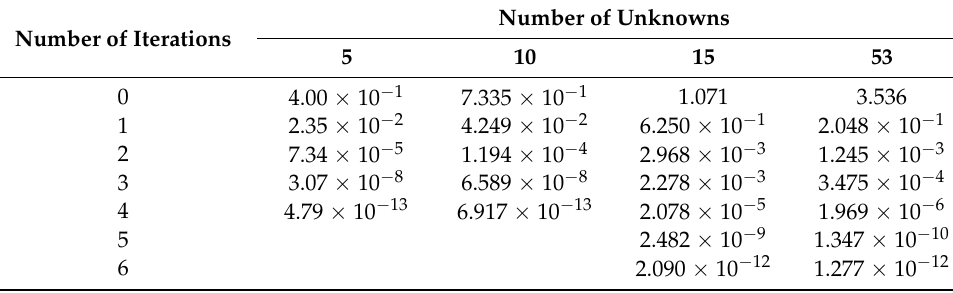
Table 9. Convergence process of the objective function under different